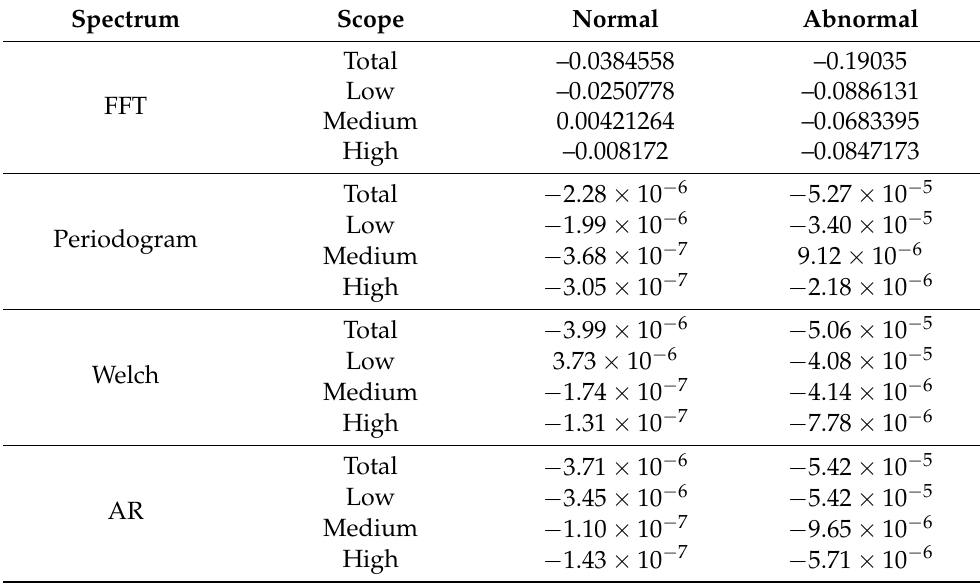
Table 1. Spectral powers for normal and abnormal